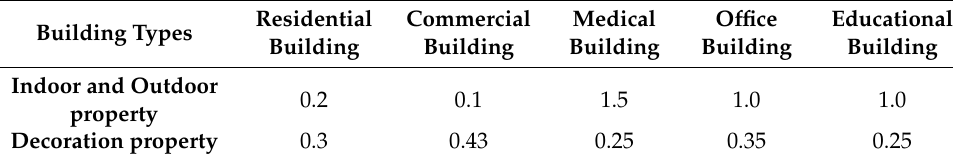
Table 3. Ratio of the replacement cost to the construction